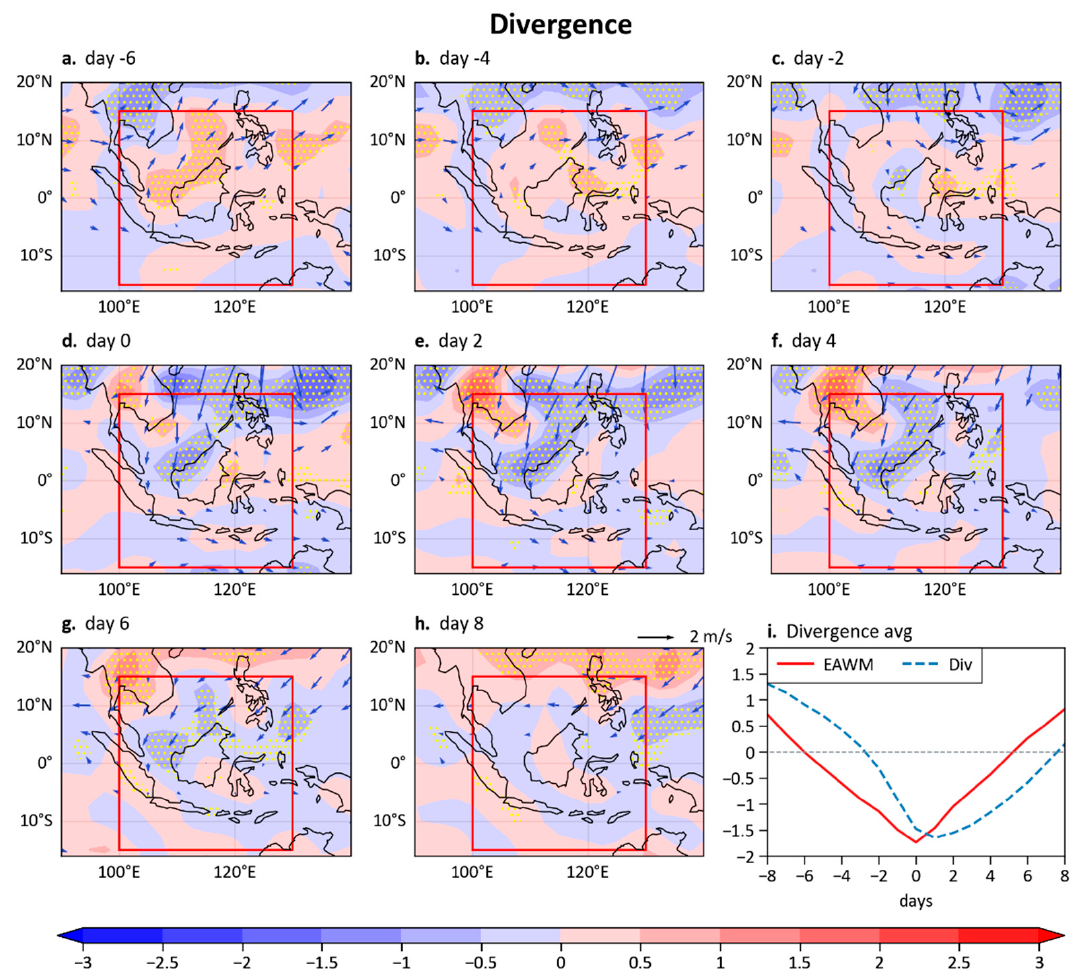
Figure 4. ( a – h ) Composite anomalies of 1000 hPa divergence (color, 10 − 6 s − 1 ) and winds (vector, m s − 1 ) at days − 6 to 8 with an interval of 2 days during the strong EAWM events. Stripping regions indicate the divergence anomalies exceed the 95% confidence level. Only meridional or zonal wind anomalies that exceed the 90% confidence level are plotted. ( i ) Temporal evolutions of the composite EAWM index and area-averaged 1000 hPa divergence anomaly (normalized) in the WTP region of (15°S–15°N, 100°–130°E, red box) during the strong EAWM events.